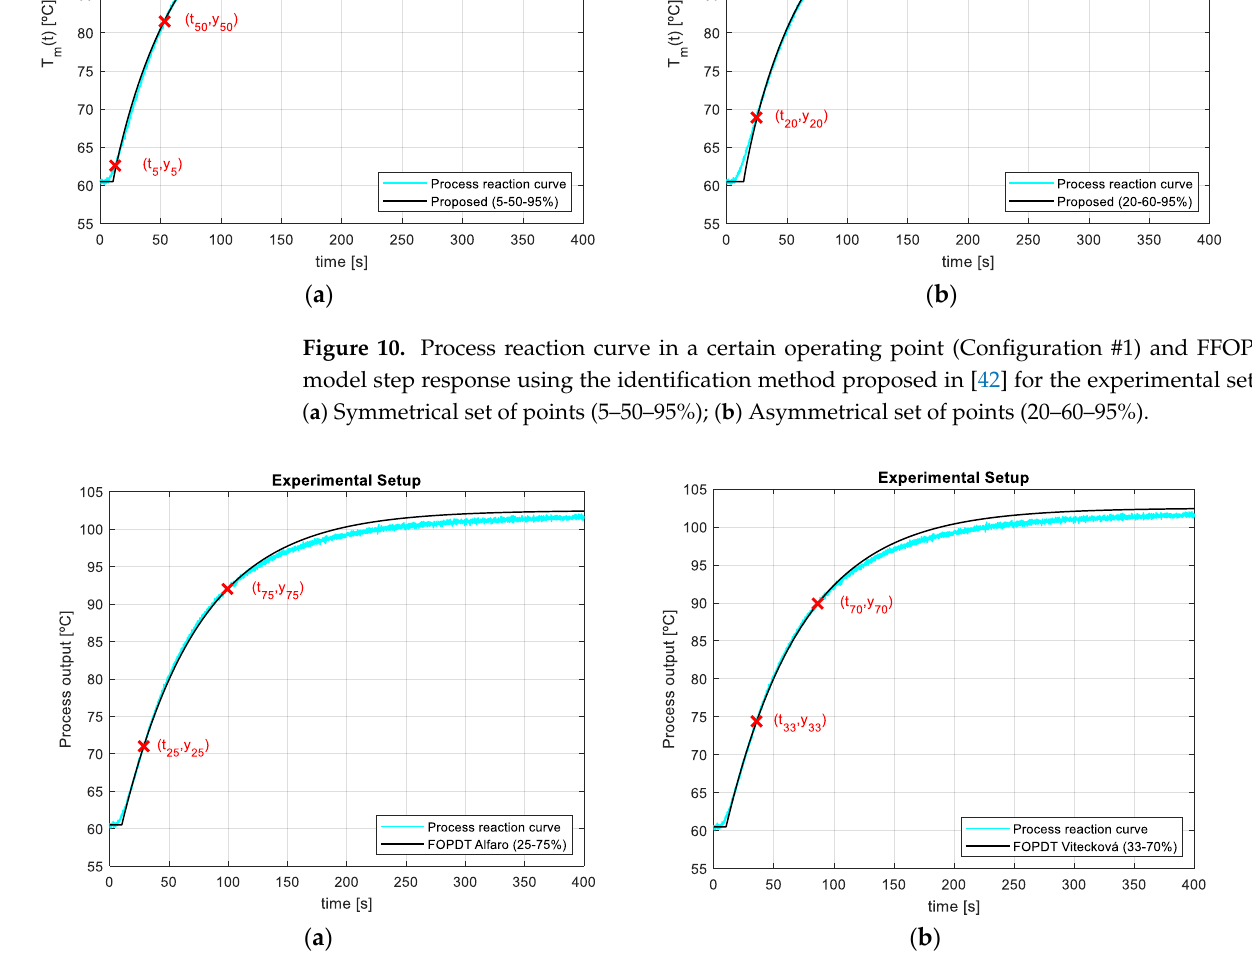
Table 8. Model performance indexes obtained for the considered identification methods for FFOPDT and FOPDT